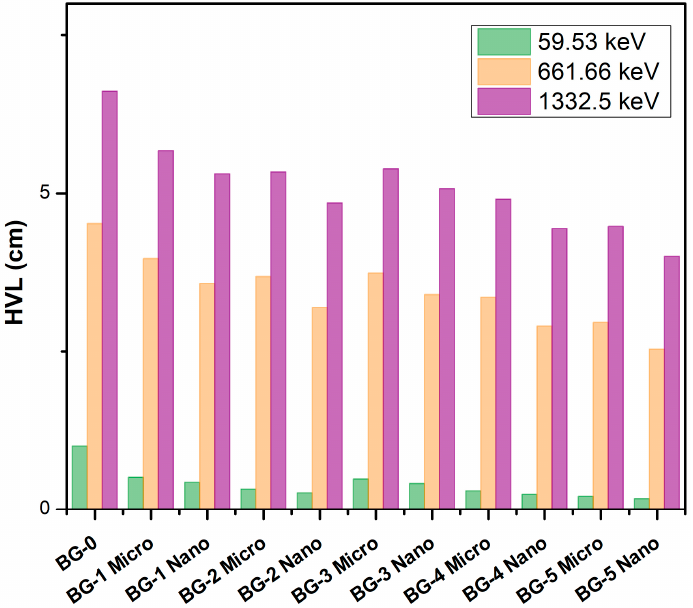
Figure 4. The half-value layer (HVL) of the Bi 2 O 3 /bentonite–gypsum composites at photon energies 59.53, 661.66, and 1332.5